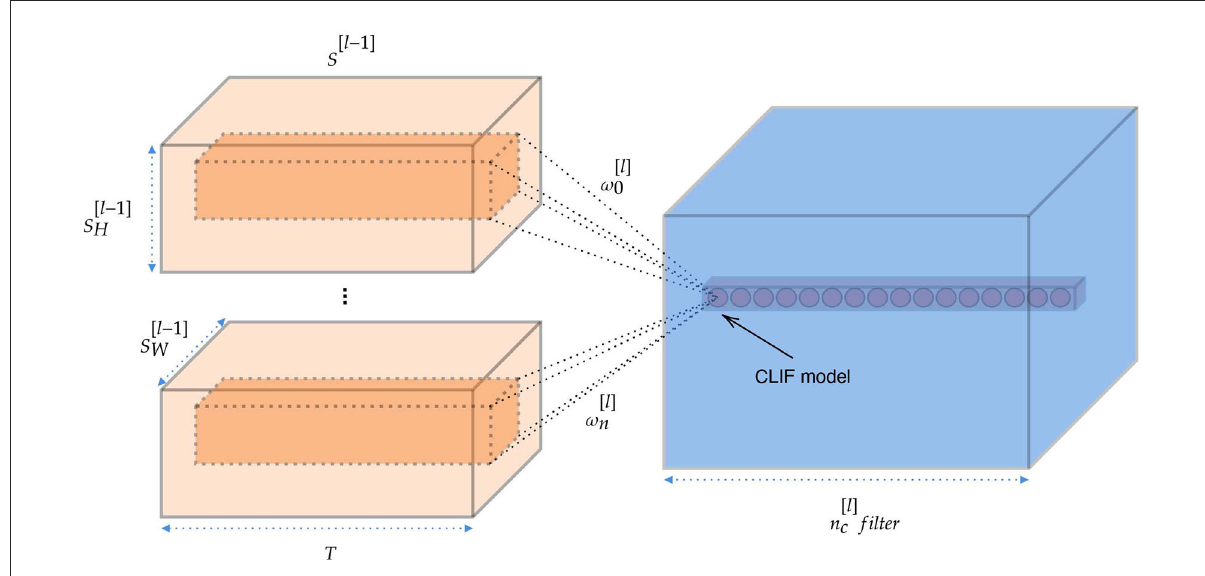
FIGURE14 The structure and information flow of spiking convolutional layer.